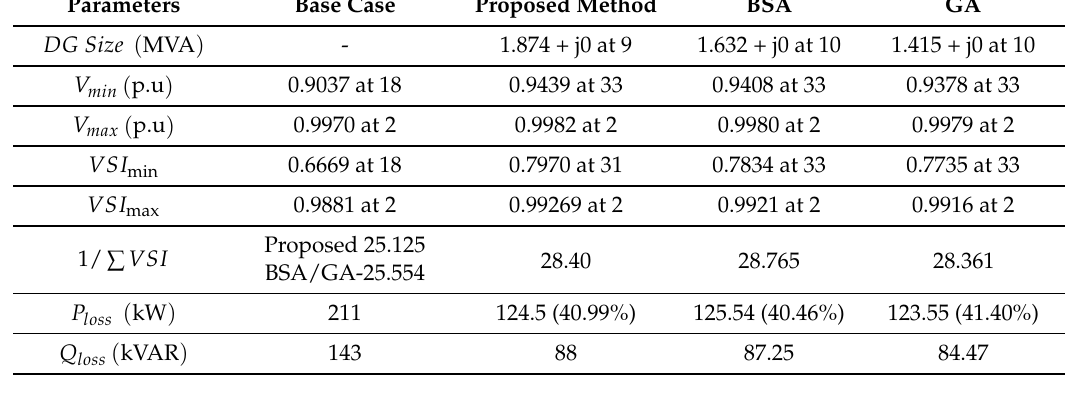
Table 7. Optimal compromise results of proposed method in comparison with BSA and GA for Type-1 (1DG) in multi-objective optimization case.